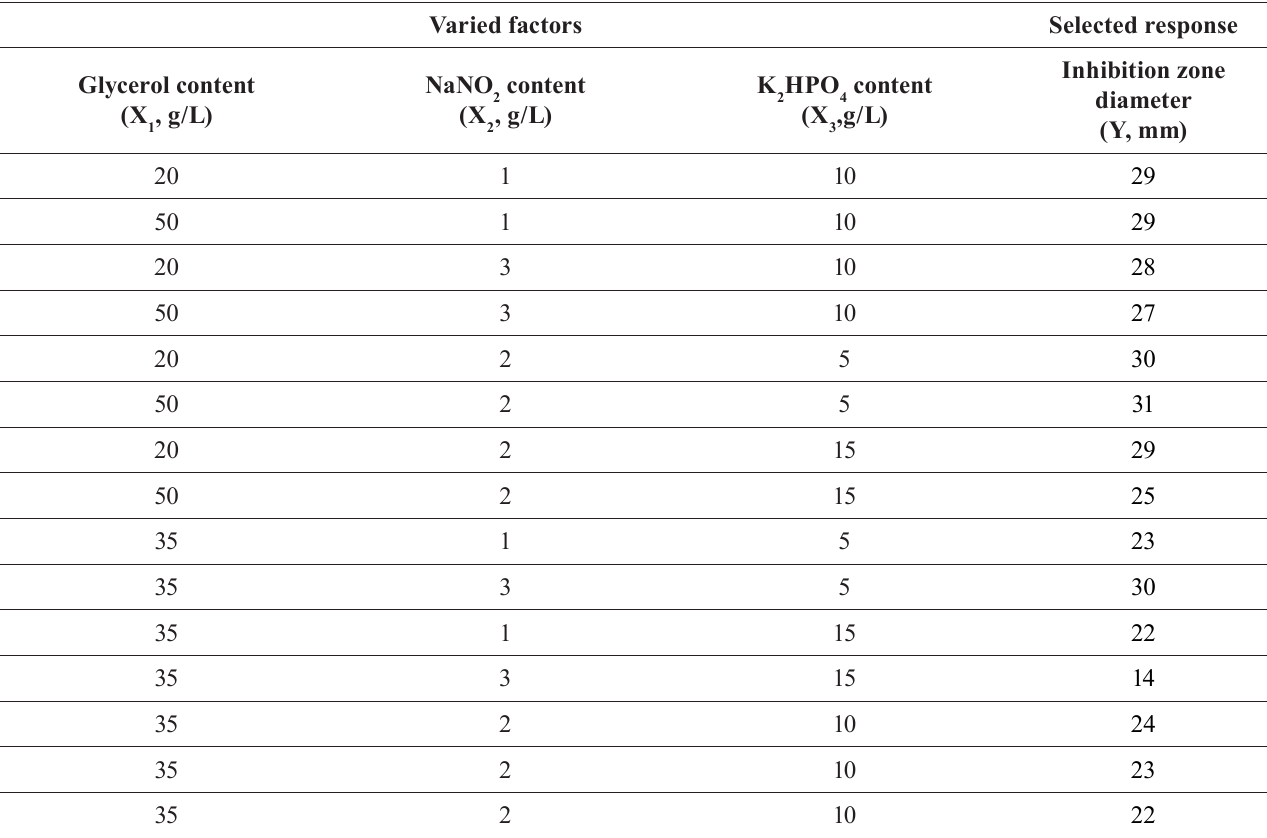
TABLE I - C ombinations of varied factors and values of selected response Varied factors Selected